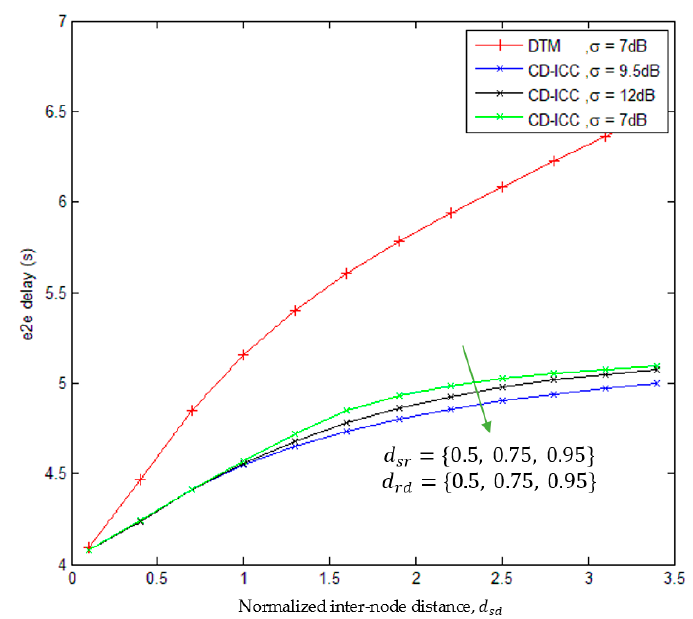
Figure 5. Comparison of e2e delay of DTM and CD-ICC with normalized inter-node distance, 𝑑 (cid:3046)(cid:3031) . In